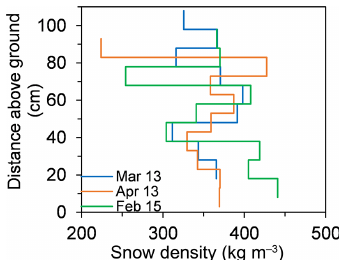
Figure 3. Observations snow density profiles on 20 March 2013, 7 April 2013, and 20 February